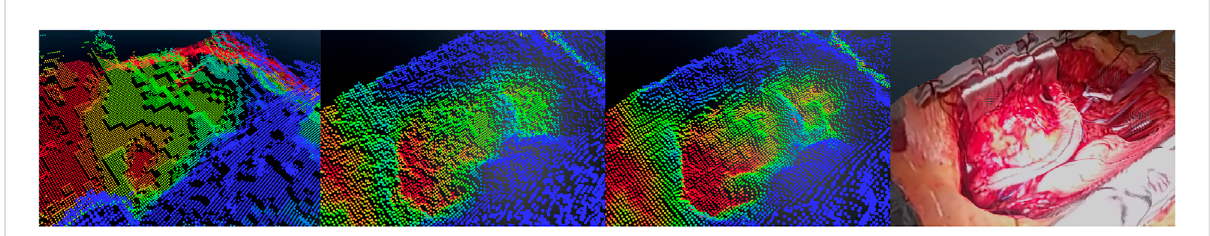
FIGURE 7 From left to right: Rendering of depth maps of the MRRTC-encoded depth map with low bandwidth (1), with high bandwindth (2) and full- resolution ROI (3). The fi nal reconstruction (4) is provided for reference.